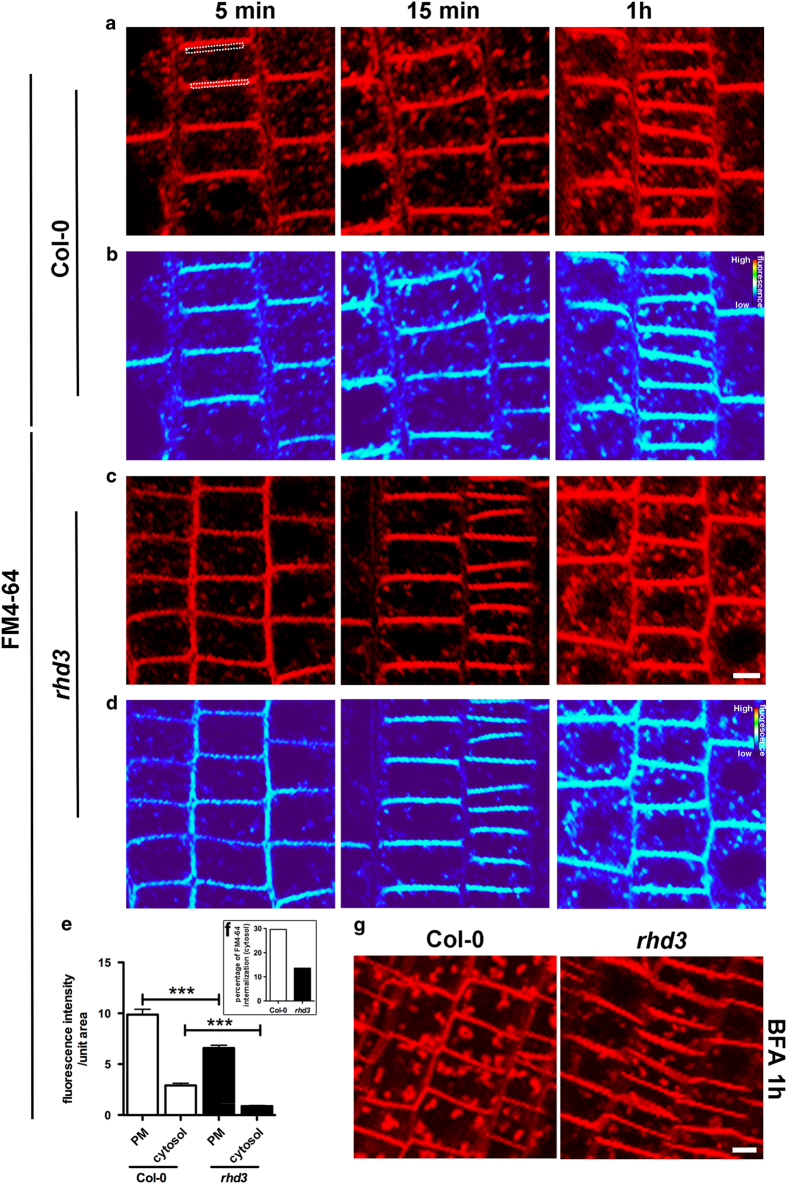
Endocytosis is delayed in rhd3. (a, c) Time course (5 min, 15 min, 1 h) to follow uptake of the endocytic tracer FM4-64 in Col-0 and rhd3 seedlings. (b, d) Fluorescence signal intensities represented as heat map facilitates visualization of levels of FM4-64 uptake in the two genetic backgrounds. (e) The graph shows a quantification of the FM4-64 signals in the root epidermis (fluorescence signal, after 5 min of FM4-64 treatment, was measured at plasma membrane and cytosol as indicated by the white dashed rectangles in a). Statistical analysis was performed using Student’s t-test (***P<0.0001). (f) The graph represents the percentage of FM4-64 internalized looking at the cytosolic area. (g) BFA bodies observed in the maximal projection of confocal images of 6-day-old Arabidopsis seedlings (Col-0 and rhd3 root epidermal cells) pulsed with FM4-64 marker and treated with 100 μM BFA for 1 h. BFA, brefeldin A.